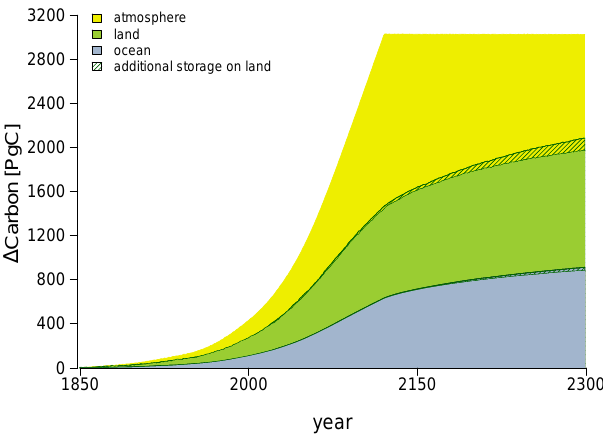
Fig. 10. Cumulated carbon budget simulated with the static pre- industrial vegetation cover. The shaded areas reflect the additional carbon storage on land due to vegetation cover changes. This ad- ditional land carbon storage leads to reduced carbon in the ocean (dark green shade over grey area) and in the atmosphere (dark green shade over yellow area).